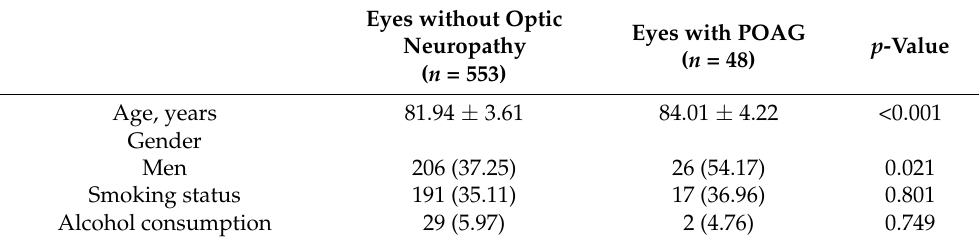
Table 2. Baseline characteristics of eyes without optic neuropathy and eyes with primary open-angle glaucoma in the Montrachet study, n =